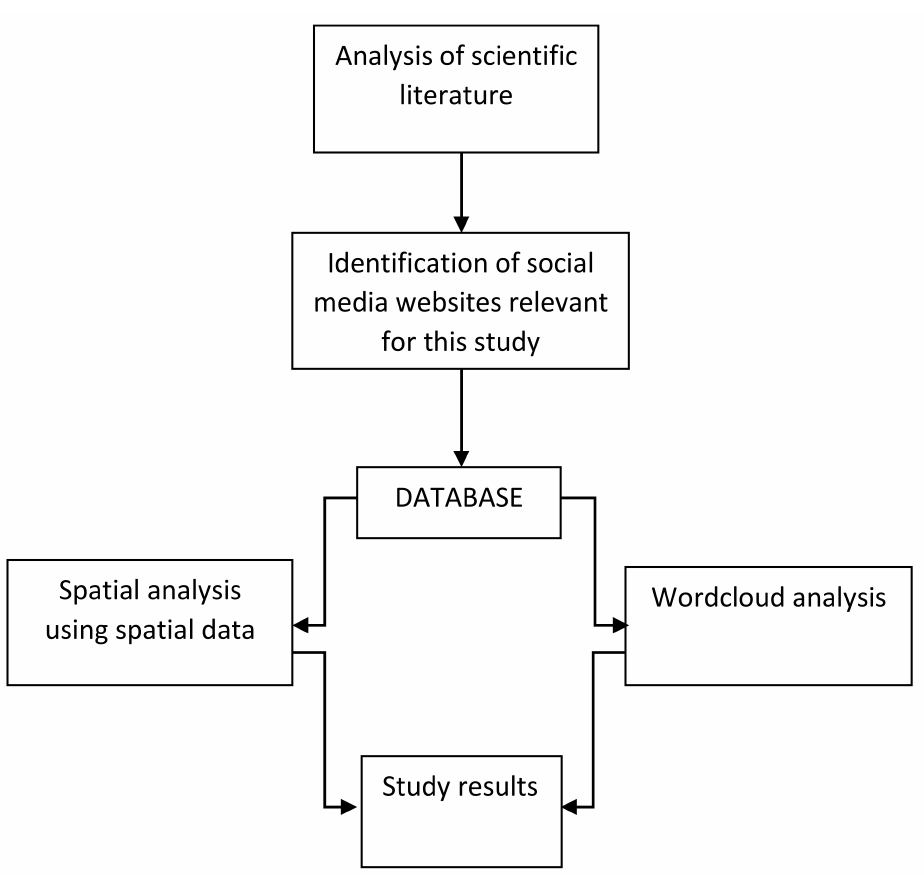
Figure 2. Schematic study